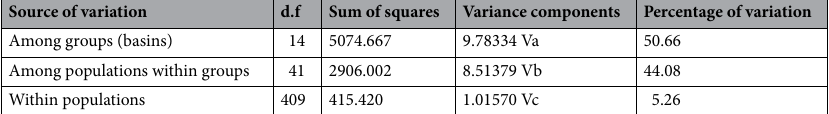
Table 3. Analysis of molecular variance (AMOVA) of Parastacus pugnax populations, considering the basins as groups and localities as populations. The three hierarchical level of variation showed significant structuring (p <